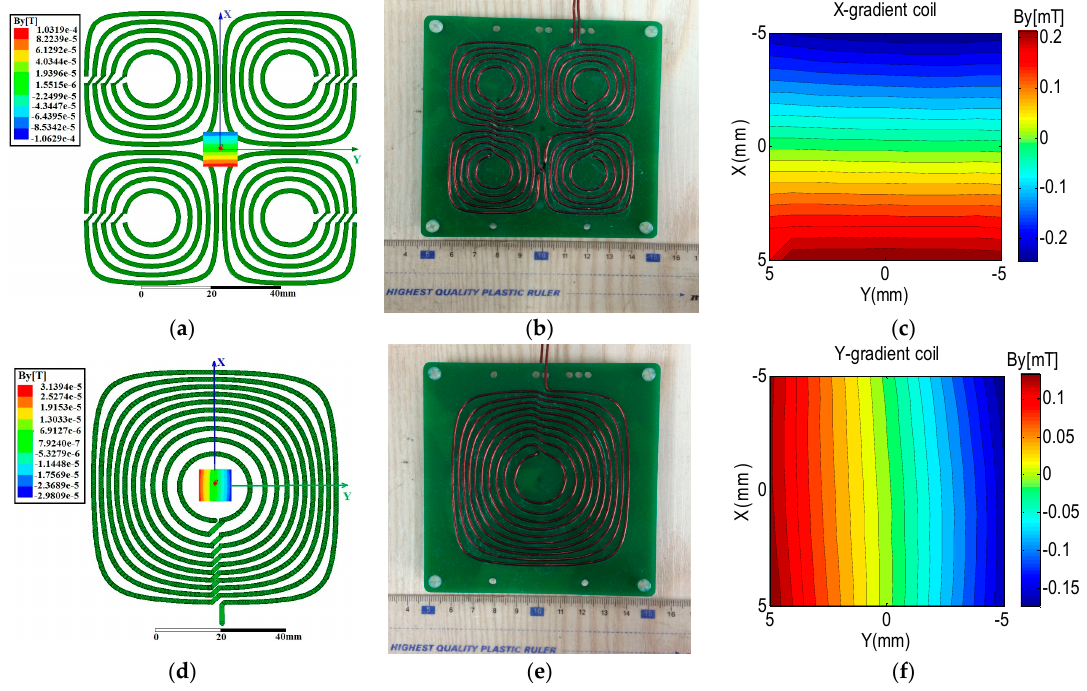
Figure 3. ( a ) Coil winding and gradient field simulated in the Maxwell 3D software for x -gradient coil; ( b ) Practical x -gradient coil; ( c ) Measured gradient field of the x -gradient coil; ( d ) Coil winding and gradient field simulated in the Maxwell 3D software for the y -gradient coil; ( e ) Practical y -gradient coil; ( f ) Measured gradient field of the y -gradient coil. Gradient field was linear for x - and y -gradient coils.